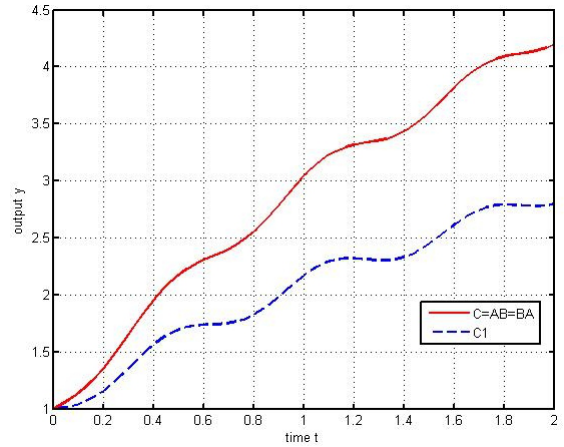
Fig. 1. Output of C and its cascade synthesis AB and BA for Example